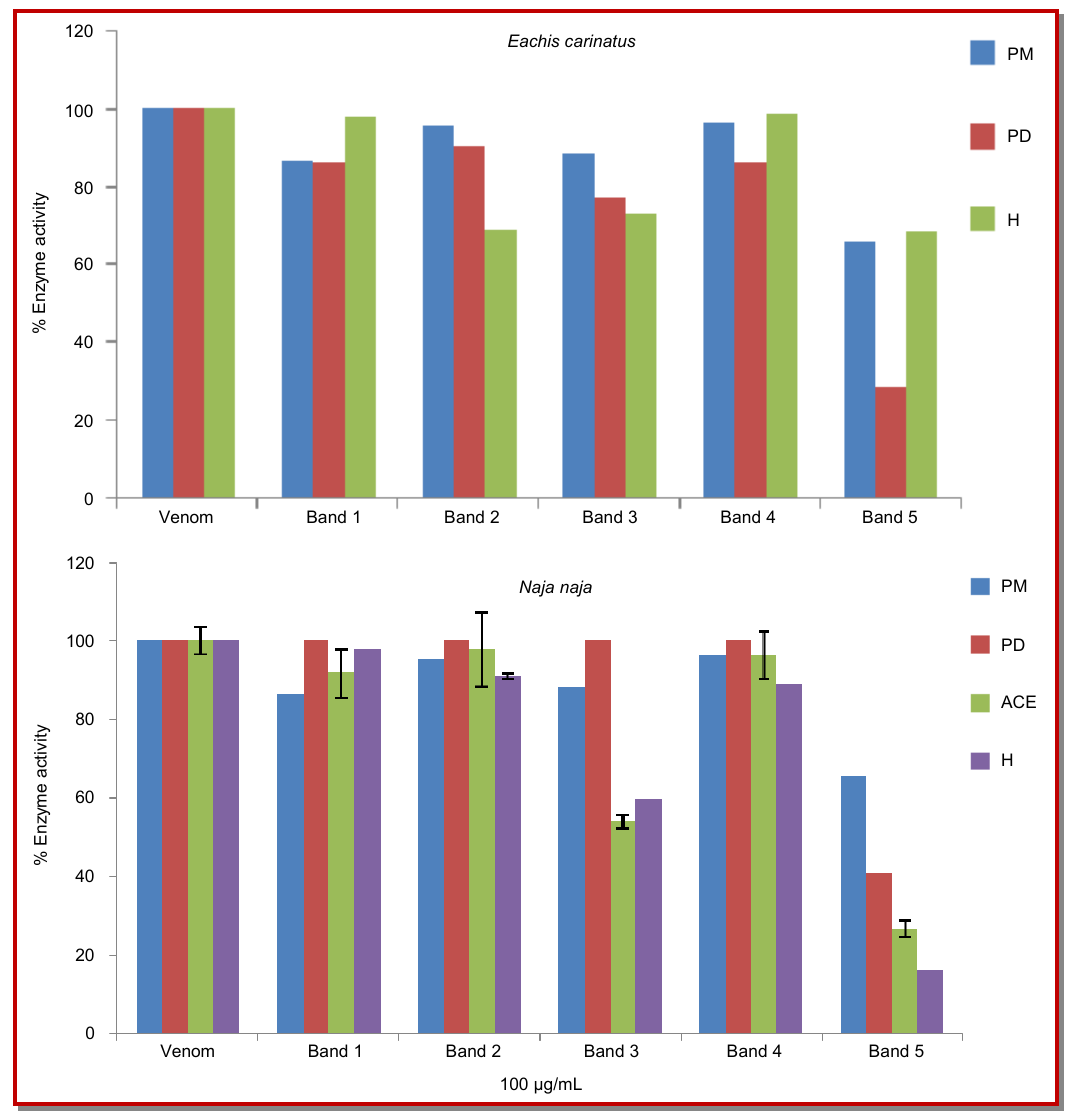
Figure 2: Neutralization of phosphomonoesterase (PM), phosphodiesterase (PD), acetylcholinesterase (ACE), hyaluronidase (H) activities of E. carinatus or Naja naja venom by TLC separated methanol extracts. Results were expressed mean ±